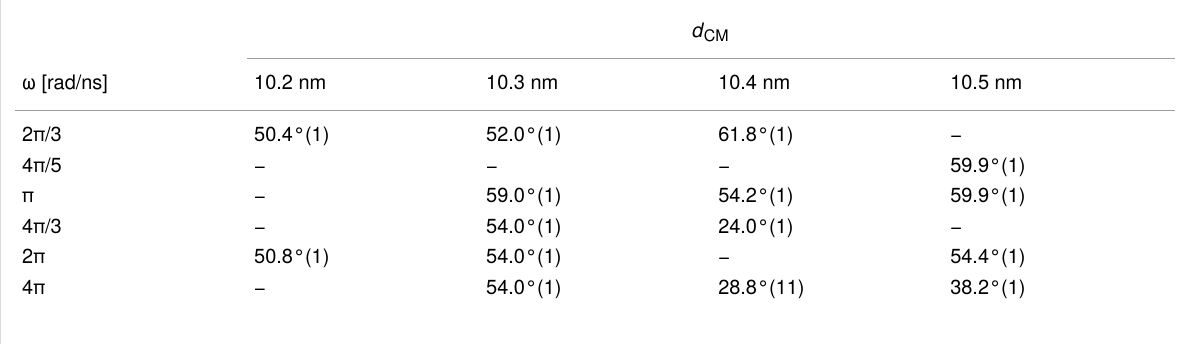
Table 1: Analysis of C–C bond formation between gears for different center-of-mass distances d CM and angular velocities of the first gear ω in units of nm and rad/ns, respectively. The MD simulations are all performed with normalized simulation time ω t = 1.2 corresponding to two steps of rotation of the first gear. The values in the table represent the angle displacement of the first gear when the bond formation happens, the number in parentheses denotes the number of bonds formed within that time frame and a minus symbol ( − ) denotes no bond formation until the end of the simulation.